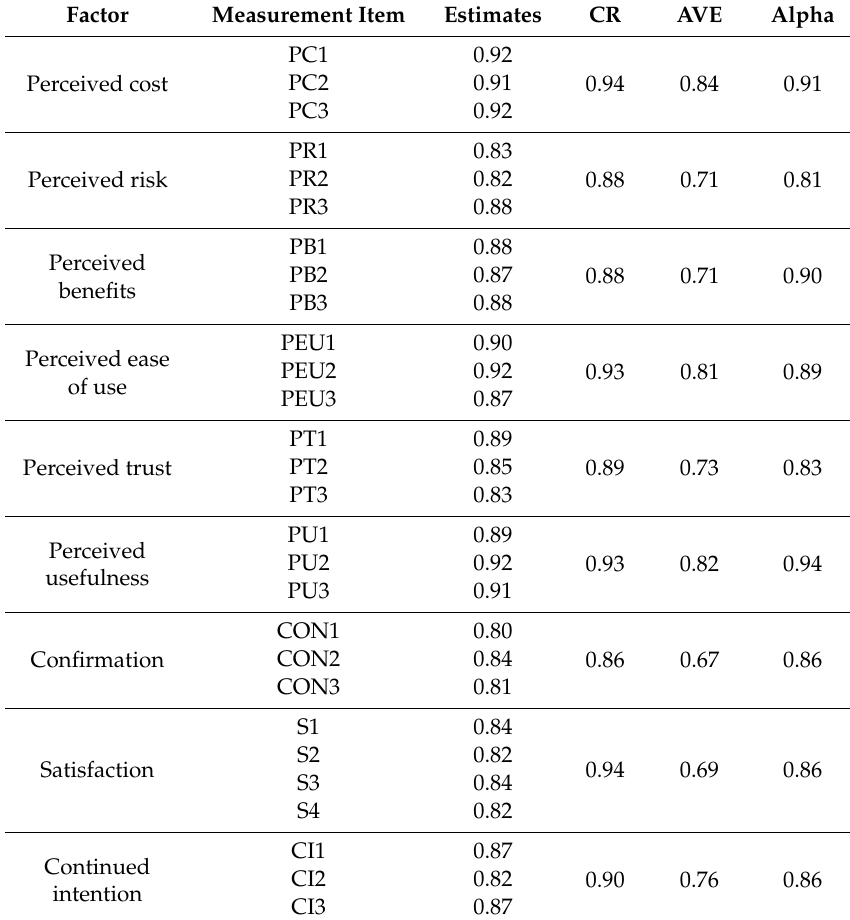
Table 2. Results of measurement model (with factor loads, CR (Composite Reliability), AVE (Average Variance Extracted), and Cronbach’s